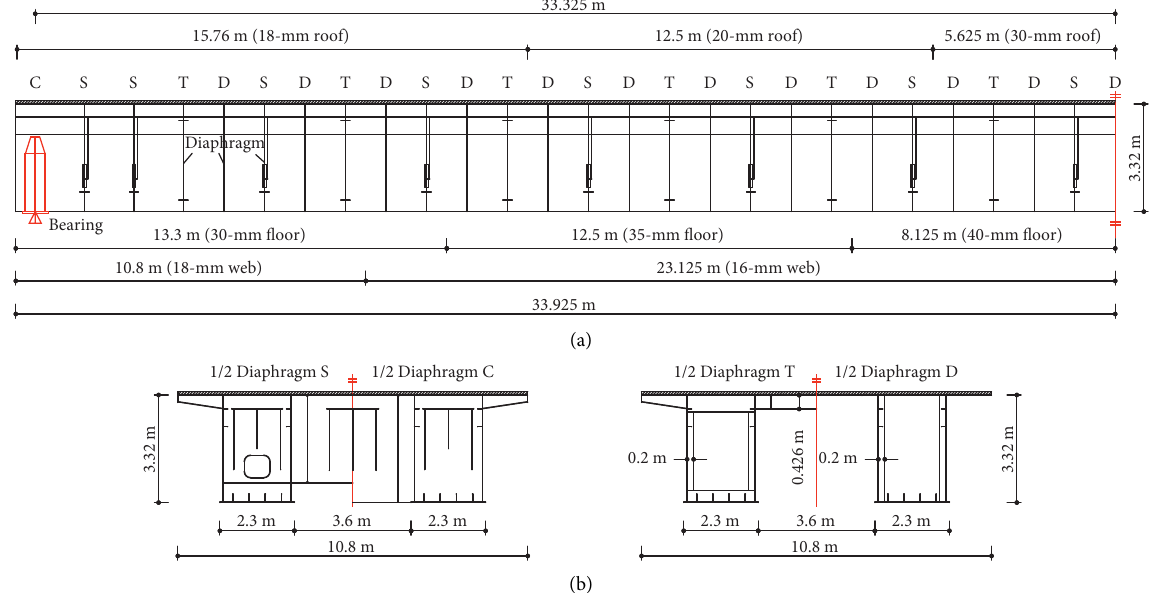
Figure 3: Structural profile of bridge girder: (a) elevation view of main plates; (b) section view of diaphragms S, C, T, and